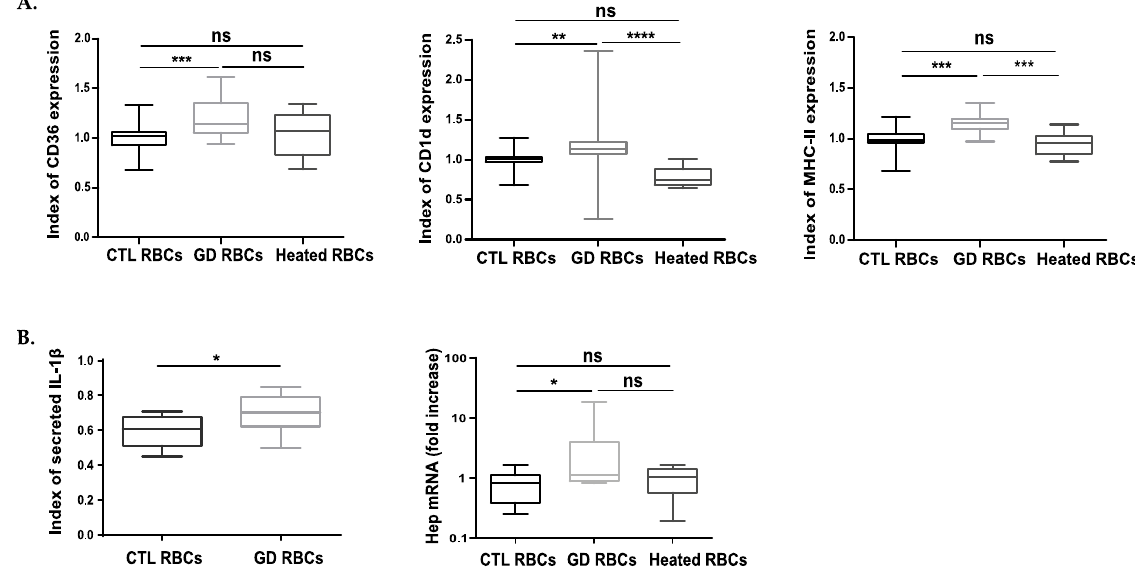
Figure 4. The phagocytosis of GD RBCs induces phenotypic modifications of macrophages toward Gaucher cells phenotype. ( A ) The expression of different markers was investigated at the surface of THP1-derived macrophages after 12 h of phagocytosis of CTL ( n = 20), GD ( n = 18), or CTL Heated ( n = 8) RBCs. The expression levels of the phagocytic marker CD36, as well as the immunological markers MHC-II and CD1d antigen, were evaluated by flow cytometry. The charts represent the index of marker expression. Group comparison was performed using a Kruskal-Wallis test for CD1d and CD36 and an ordinary one-way ANOVA for MHC-II. ** p < 0.01; *** p < 0.001; **** p < 0.0001. ns = non-significant. ( B ) Left panel: Secretion levels of IL-1 β were measured by ELISA. The charts represent the index of secreted cytokine in the supernatant of macrophages having engulfed CTL ( n = 12) or GD ( n = 13) RBCs. Group comparison was performed using an unpaired t -test. * p < 0.05. Right panel: hepcidin mRNA (Hep) quantification by qRT-PCR in macrophages 3 h after phagocytosis of CTL ( n = 7) or GD ( n = 7) RBCs. The charts represent the fold increase quantification of hepcidin mRNA compared to the quantification assessed in macrophages before erythrophagocytosis. Group comparison was performed using a Kruskal-Wallis test. * p < 0.05. ns = non-significant. The medians are represented as horizontal bars; the upper and lower quartiles are represented as the top and the bottom of the box, respectively; and the maximum and minimum data values are shown by dashes at the top and the bottom, respectively, of the whiskers.